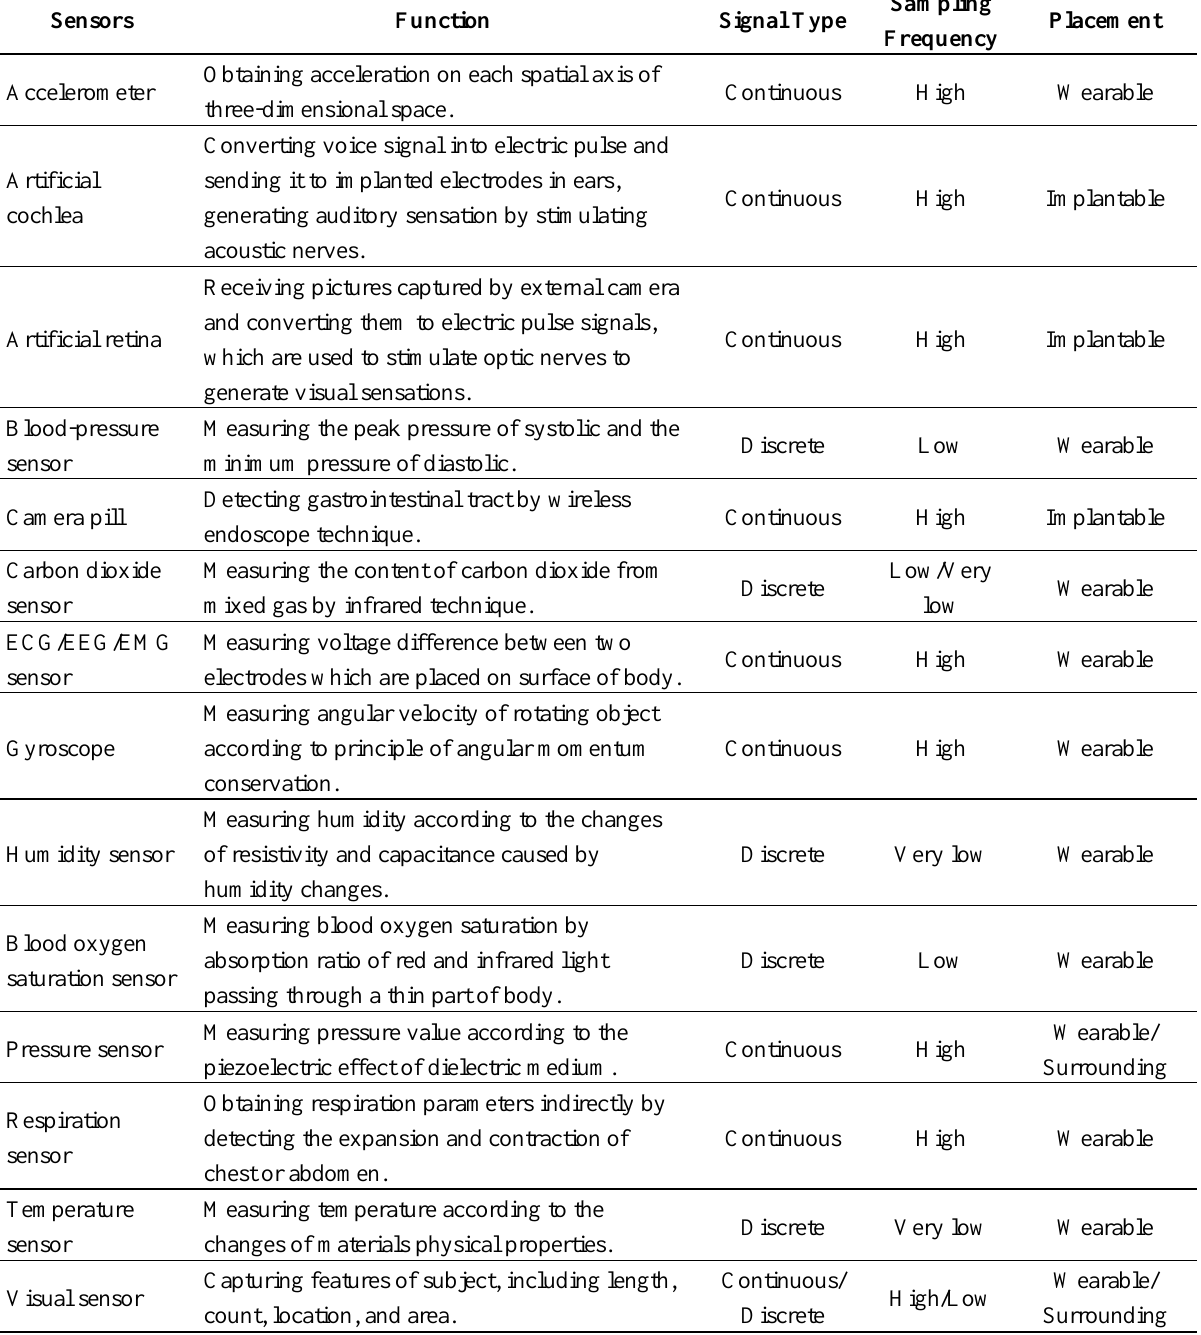
Table 1. Commonly used sensors in